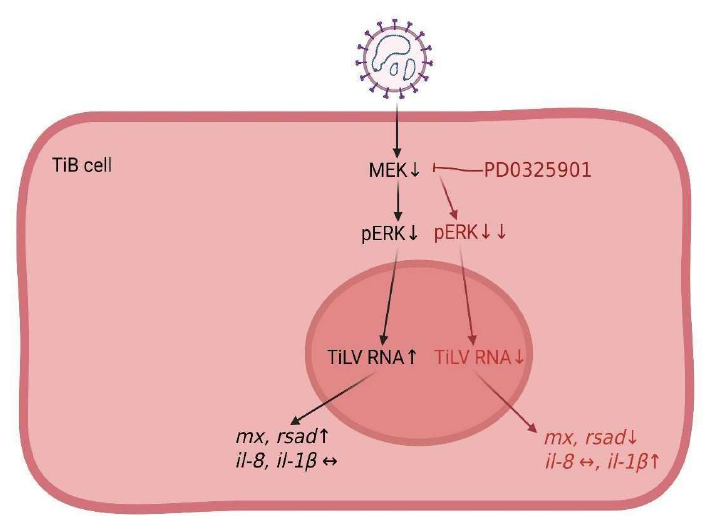
Figure 7. A schematic diagram illustrating the involvement of MEK/ERK signalling pathways and host-cell immune-related genes during early TiLV infection (in black). The importance of MAPK/ERK signaling in TiLV infection is elucidated by treating the cells with PD 0325901 (in red).